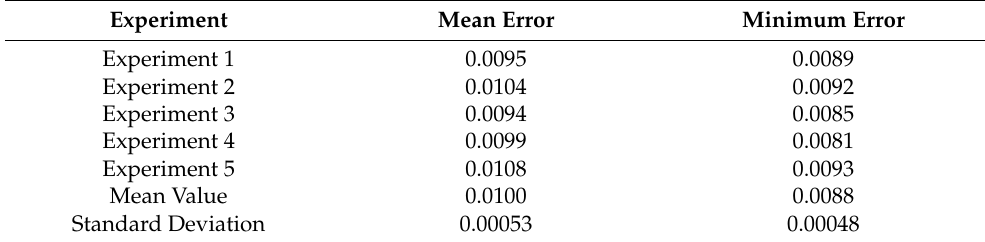
Table 17. Mean and standard deviation of 5 experiments on MNIST.